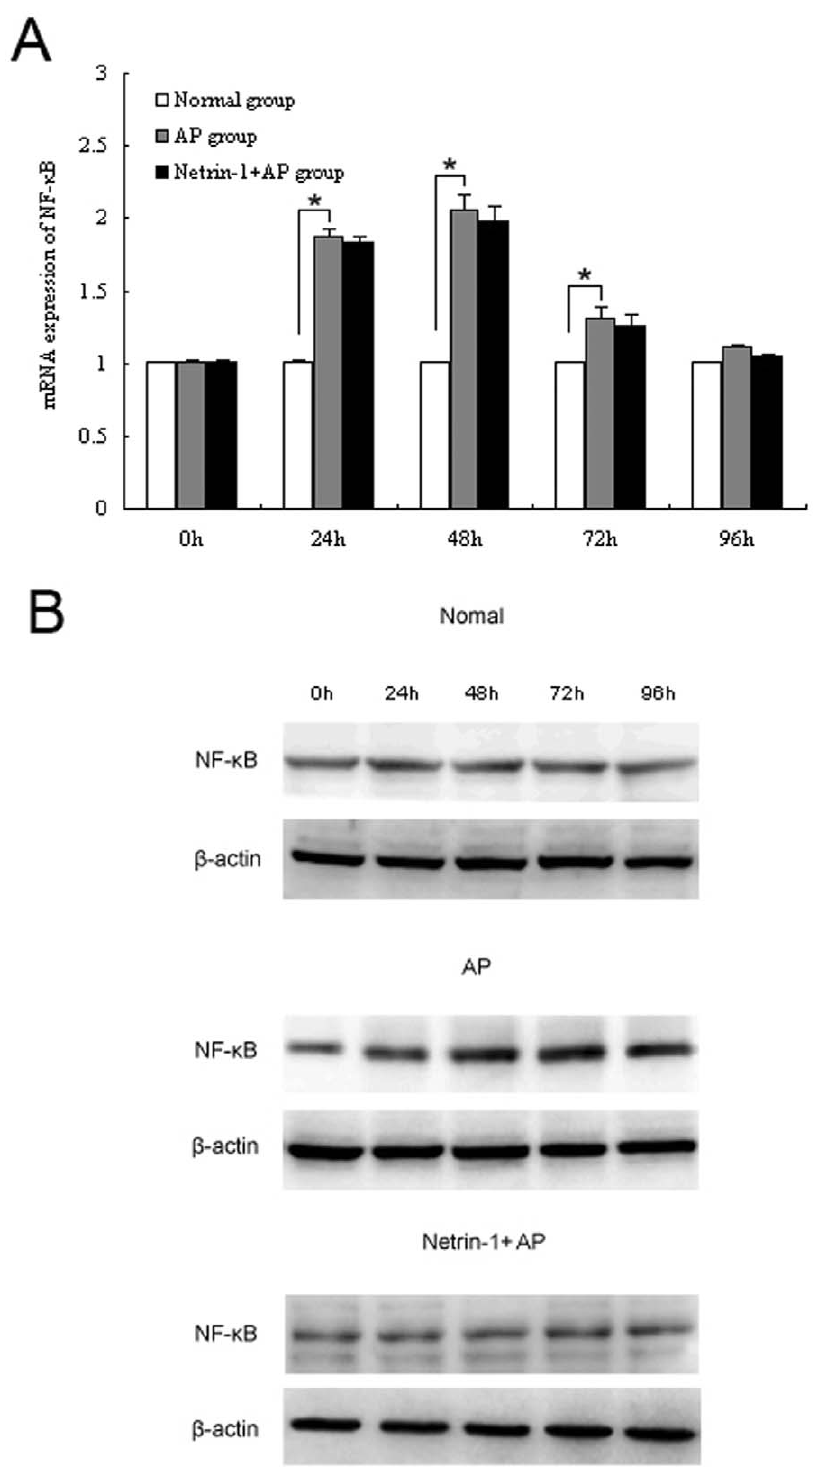
Figure 5. Effect of netrin-1 on pancreatic NF- k B activation. RT-PCR (A) and Western blot analysis (B) of NF- k B p65 expression at the indicated times are shown for the normal group and AP groups with and without netrin-1 treatment. Acute pancreatitis was induced by two intraperitoneal injections of L-Arginine (4 g/kg, 1 h apart). Mice were treated with recombinant mouse netrin-1 at a dose of 1 m g/mouse or vehicle (0.1% BSA) immediately after the second injection of L-arginine and every 24 h thereafter. Data are presented as mean 6 SD (n=6 per group in the normal mice, n=8 per group both in the AP model and netrin-1 treated AP model). * P , 0.05.